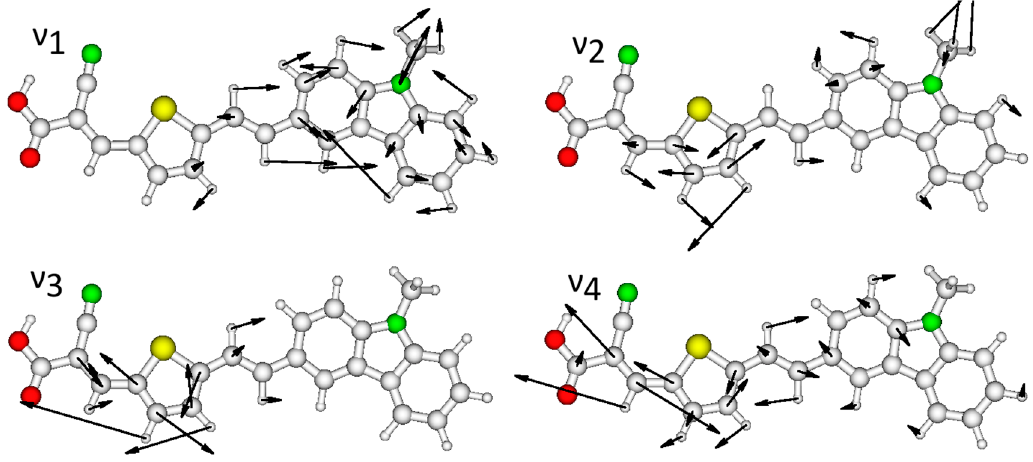
Figure 8 . Key vibrational modes of 1A , as modeled at the B3LYP/6-31G(d) level (grey = carbon, red =oxygen, green = nitrogen, yellow = sulfur and white = hydrogen).